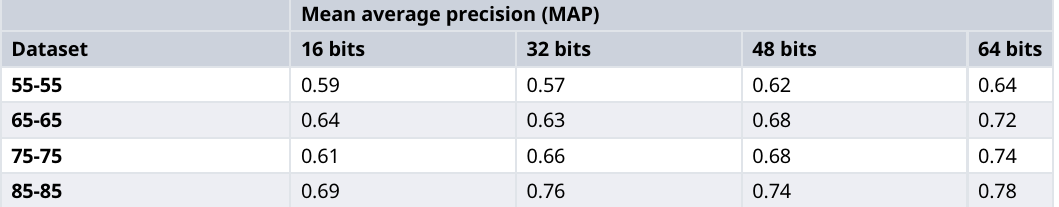
Table 5. MAP for different datasets with the mixed condition.